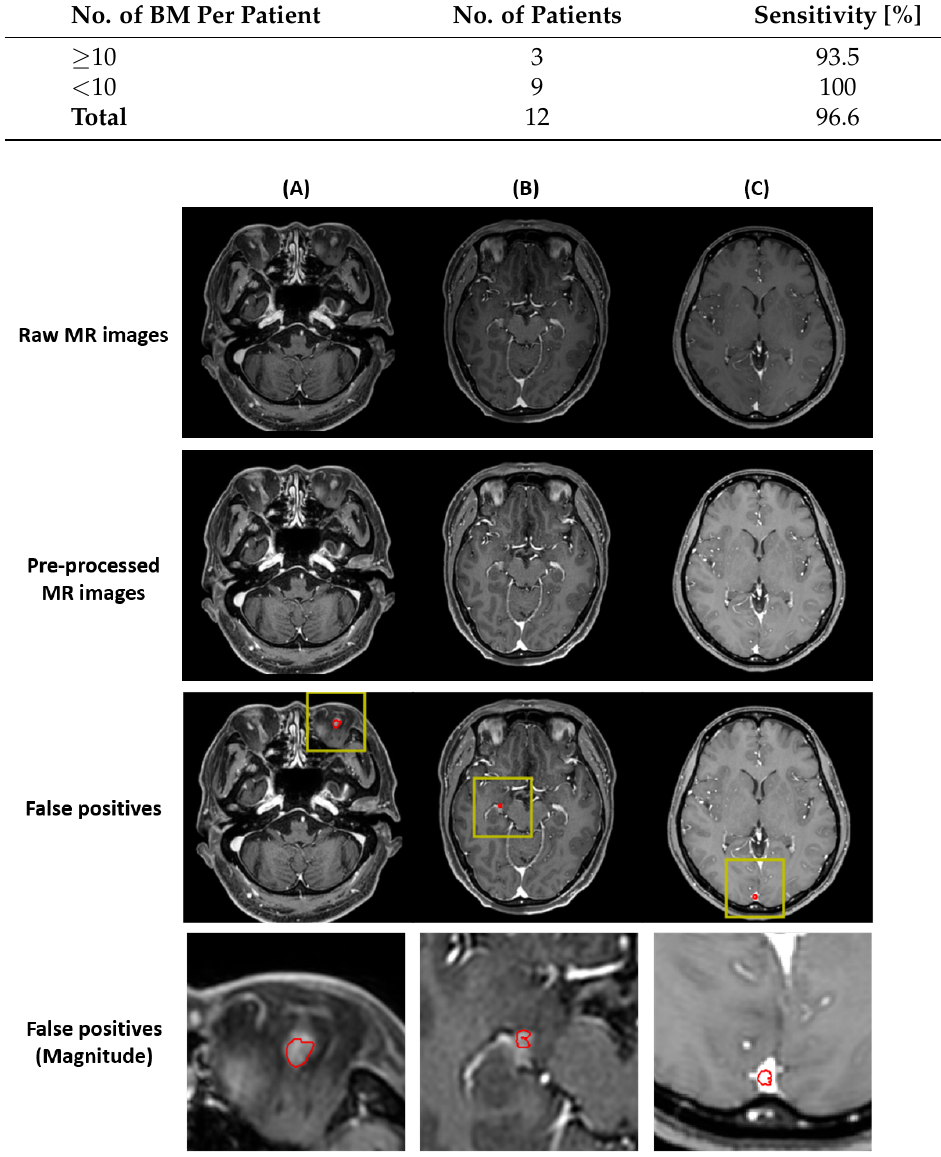
Figure 4. Locations of the false positives. ( A ) Delineation created outside the brain; can be solved with skull-stripping. ( B ) Delineation created in a structure with high intensity; can be solved with extensive gamma correction. ( C ) Delineation created in the superior sagittal sinus; can be solved with black-blood sequencing. In each images, red in the yellow bounding box indicates false